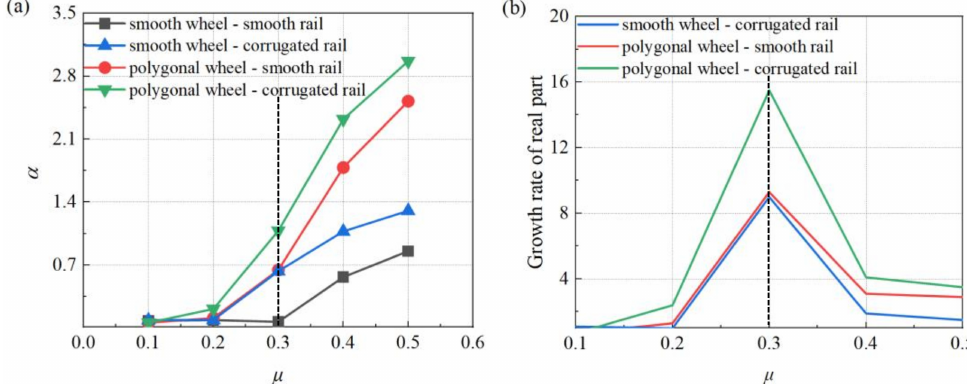
Figure 11. Effect of the wheel–rail friction coefficient on the stability of the system: ( a ) distribution of the real part; ( b ) growth rate of the real